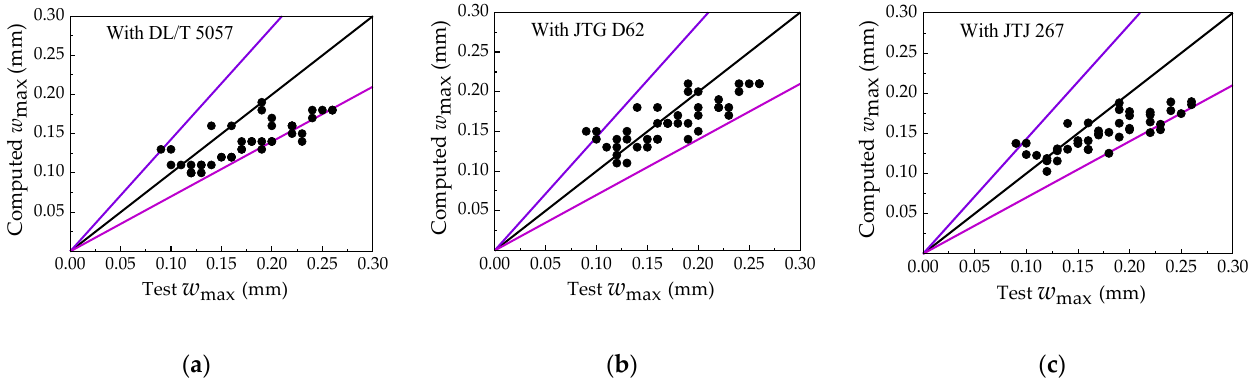
Figure 7. Comparison of test to computed maximum crack width by the formulas specified in codes: ( a ) DL/T 5057; ( b ) JTG D62; ( c ) JTJ 267.